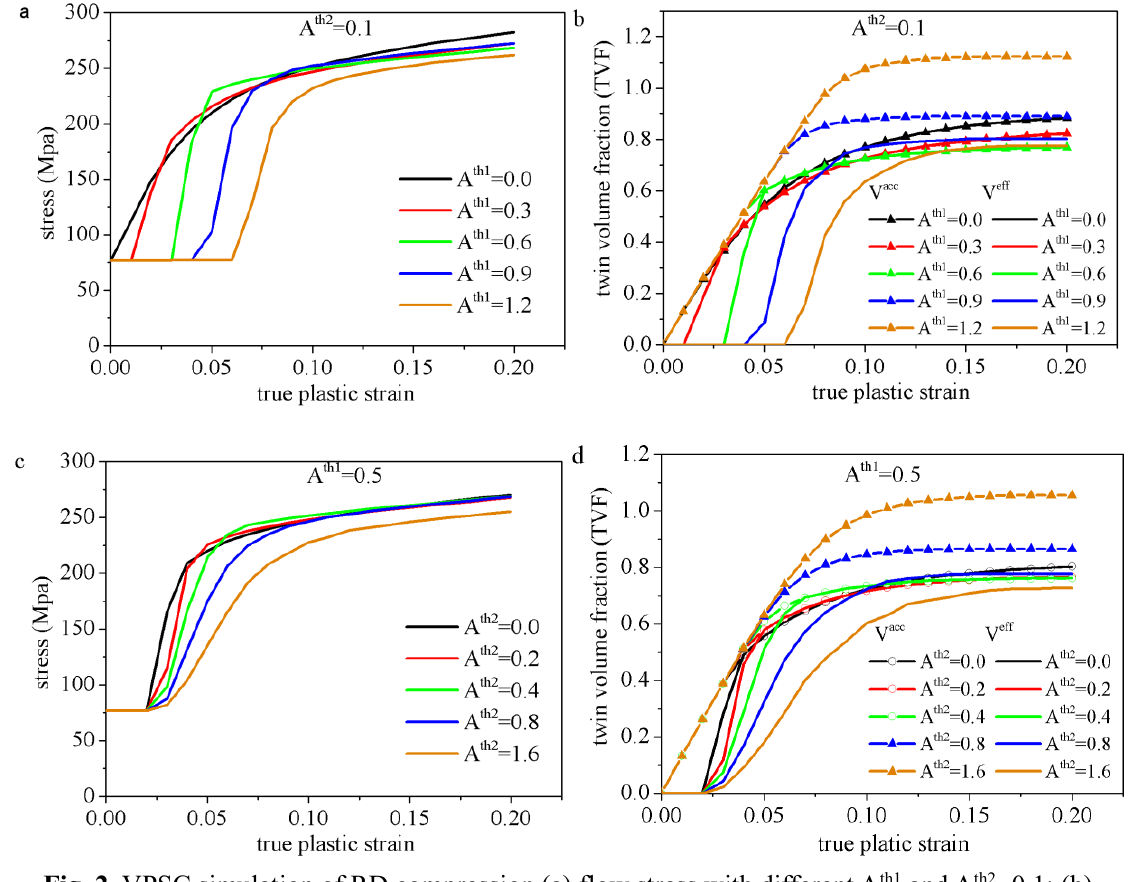
Fig. 2 . VPSC simulation of RD compression (a) flow stress with different A th1 and A th2 =0.1; (b) corresponding accumulated and effective TVF, (c) flow stress with A th1 =0.5 and different A th2 and (d) corresponding